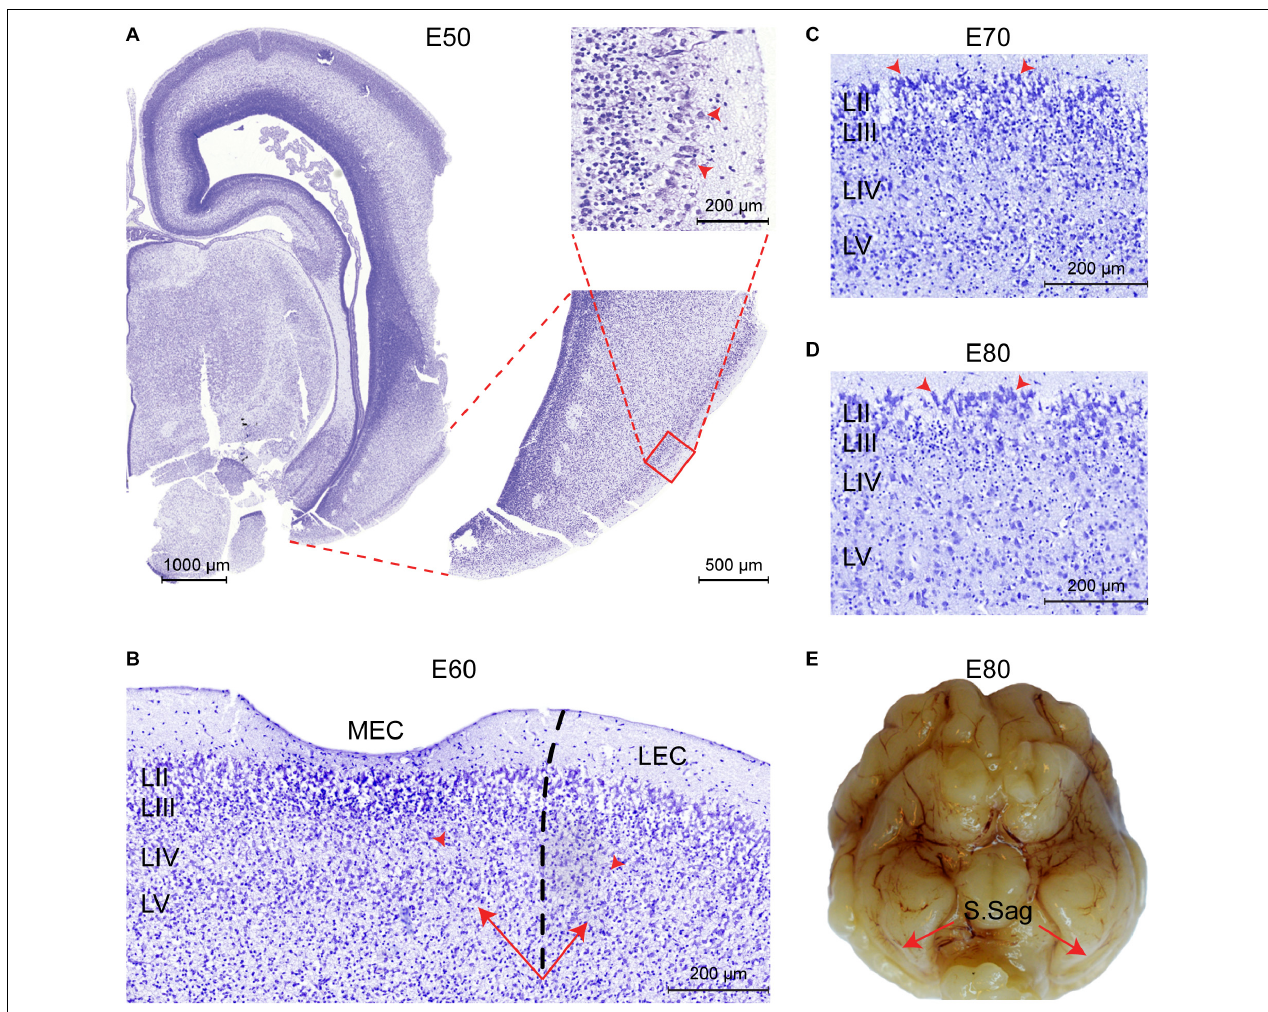
FIGURE 3 | The entorhinal cortex (EC) forms between Embryonic day (E)50 and E60 in the pig. (A) Entorhinal-like cells with large somas (red arrowheads) are identifiable at E50 in the superficial layer of the ventral telencephalon. Scale bars 1000 µ m, 500 µ m, and 200 µ m. (B) At E60 the EC becomes six-layered, the lamina dissecans becomes apparent as layer (L)VI, and the medial EC (MEC) and lateral EC (LEC) subfields of the EC become distinguishable, based on the difference in cellularity of the lamina dissecans (red arrowheads) and the deep layer (LV-LVI) organization (arrows). Scale bar 200 µ m. (C) Section of the MEC at E70. Prominent, large and darkly stained nuclei in the superficial LII (arrowheads) are apparent. Scale bar 200 µ m. (D) Section of the MEC at E80. Superficial LII cells become more prominent. Scale bar 200 µ m. (E) The sagittal sulcus (S.Sag) becomes macroscopically visible in the piriform lobe at E80 (red